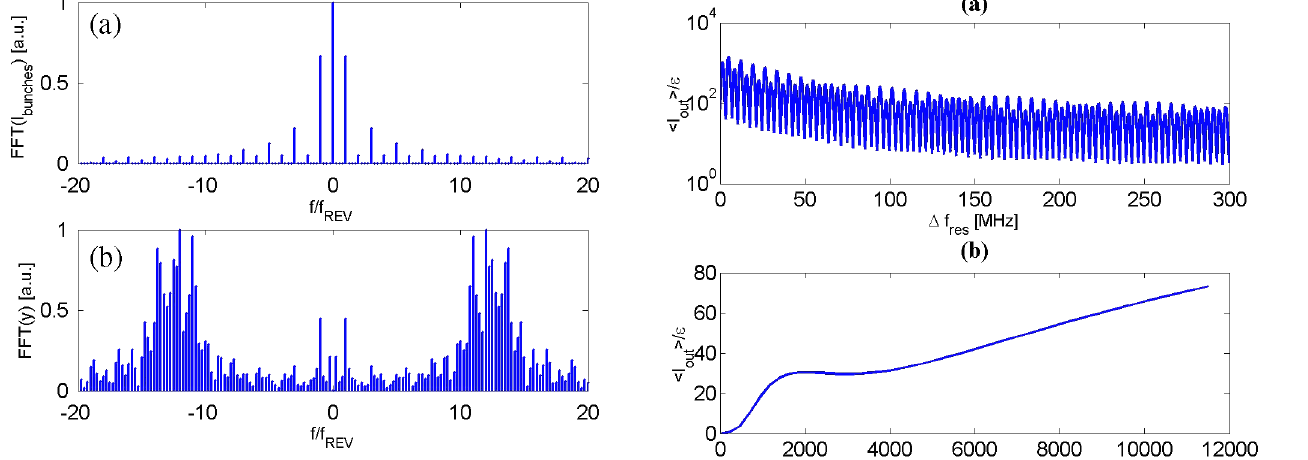
=" in the last turn (calculated over the FIG. 10. Average I out bunch train) as a function of the mode resonant frequency and ¼ 2 mm , Y ¼ 0 , (cid:5) ¼ (cid:5) ¼ 5 m , (cid:6) quality factor ( Y y 1 y 2 y 1 in1 in2